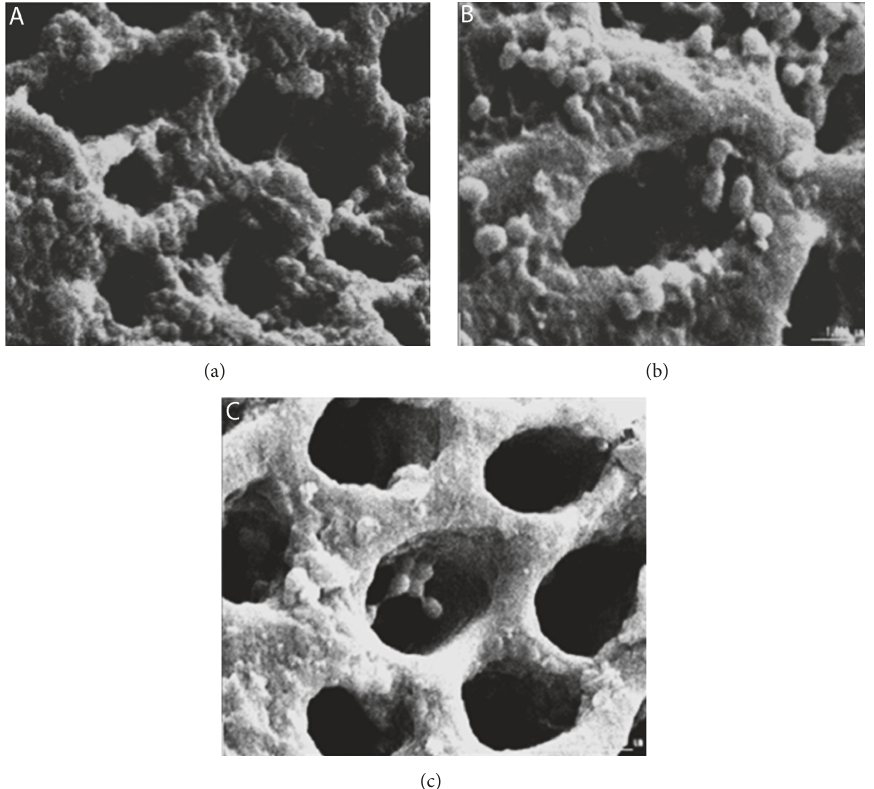
Figure 2: SEM micrographs of root canal walls and dentinal tubules. Control group: (a) E. faecalis biofilms on dentinal walls. Conventional regimen: (b) scattered E. faecalis in the root canal wall and dentin tubules entrance. Alternating regimen: (c) scarce E. faecalis in entrance dentin tubules. Magnifications: (a) 5000X, (b) 7200X, and (c)